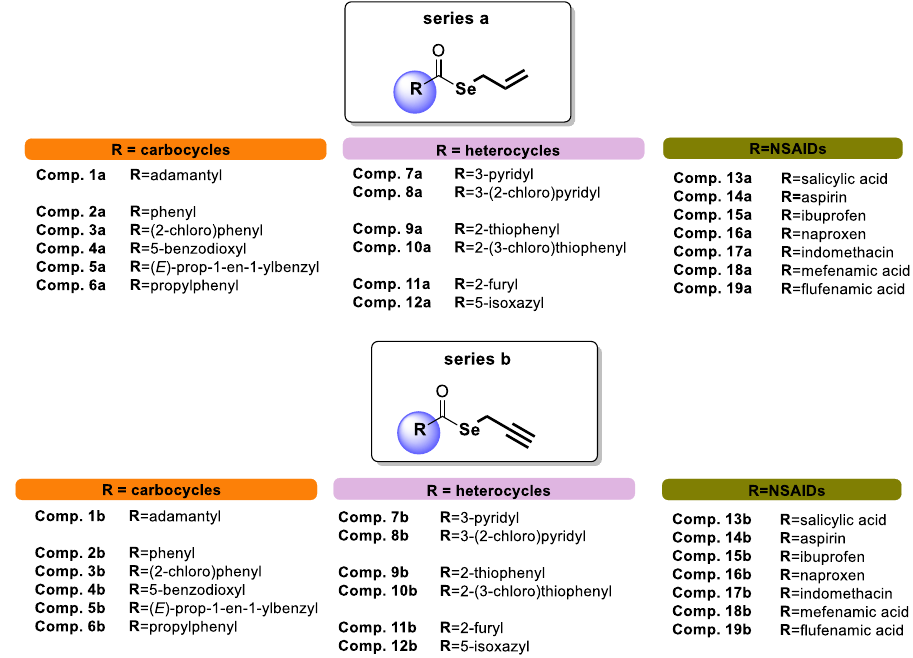
Figure 2. Structures of synthesized compounds ( 1a – 19a and 1b – 19b ).